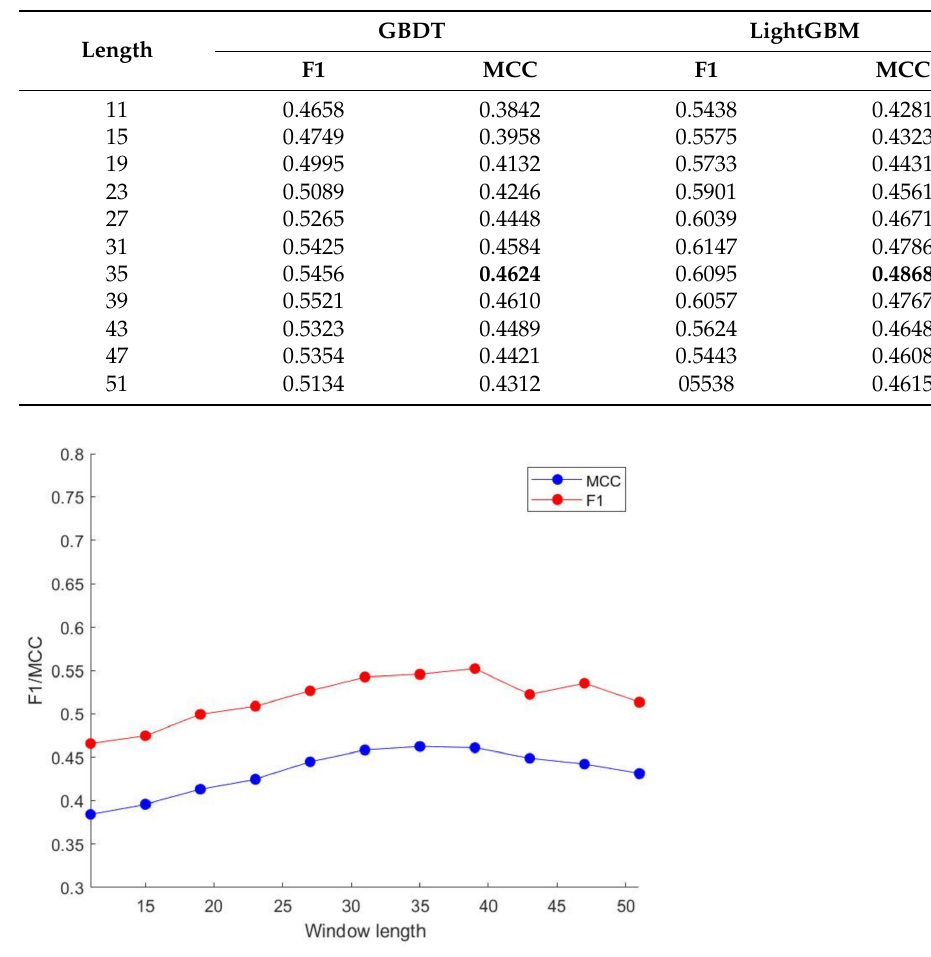
Figure 5. Different window size performance in GBDT.